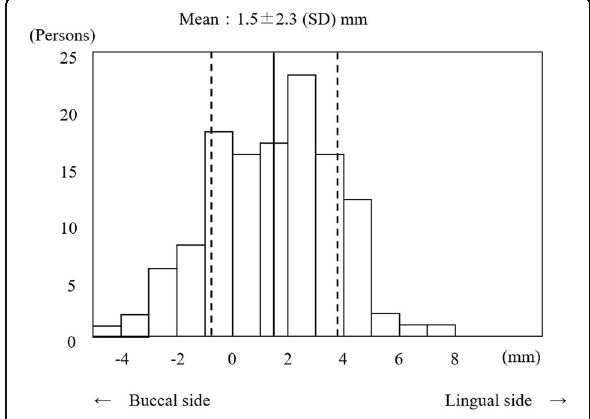
Fig. 12 Distribution of the vertical distance between the maxillary first molar and the mandibular residual ridge ( n = 123)